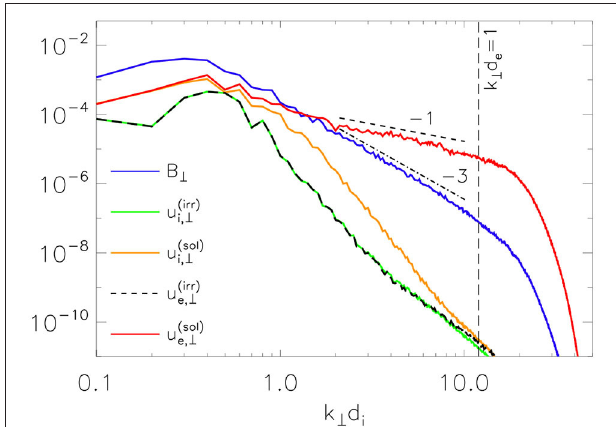
FIGURE 4 | From sim.A. Spectra at t (blue solid line), the solenoidal contributions to the in-plane ion and electron velocities u (sol) (i,e) (orange and red solid lines, respectively), and the irrotational contributions of the same velocities u (irr) (i,e) (green and black-dashed curves, respectively). Reference slopes of